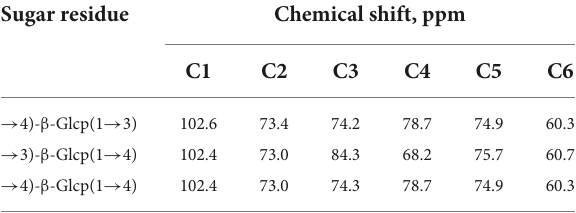
TABLE 3 Assignment of 13C NMR spectra of Qingke β -glucan